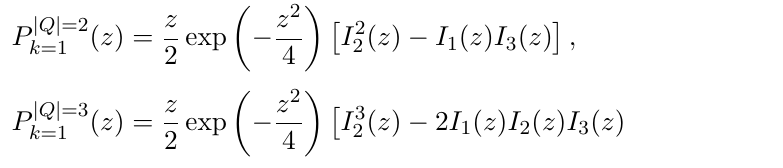
Figure 7 . The comparisons of the ratios of the eigenvalues ~ (cid:21) j Q j for each topological charge sector j Q j = 0 ; 1 ; 2. The normal con(cid:12)guration and the con(cid:12)gurations of the magnetic charges m c = 0 ; 2 ; 4 ; 6 are used. The black horizontal lines and the colored symbols indicate the prediction and the numerical results,